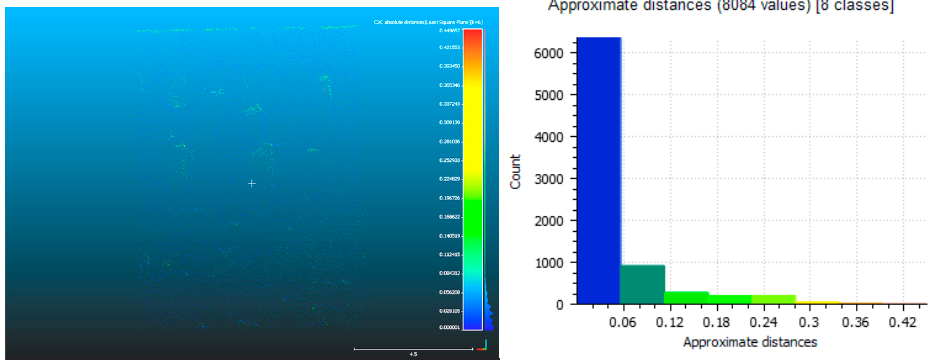
Figure 26. Discrepancy map and histogram between the TLS cloud and UAV Nadir in Pix4D.